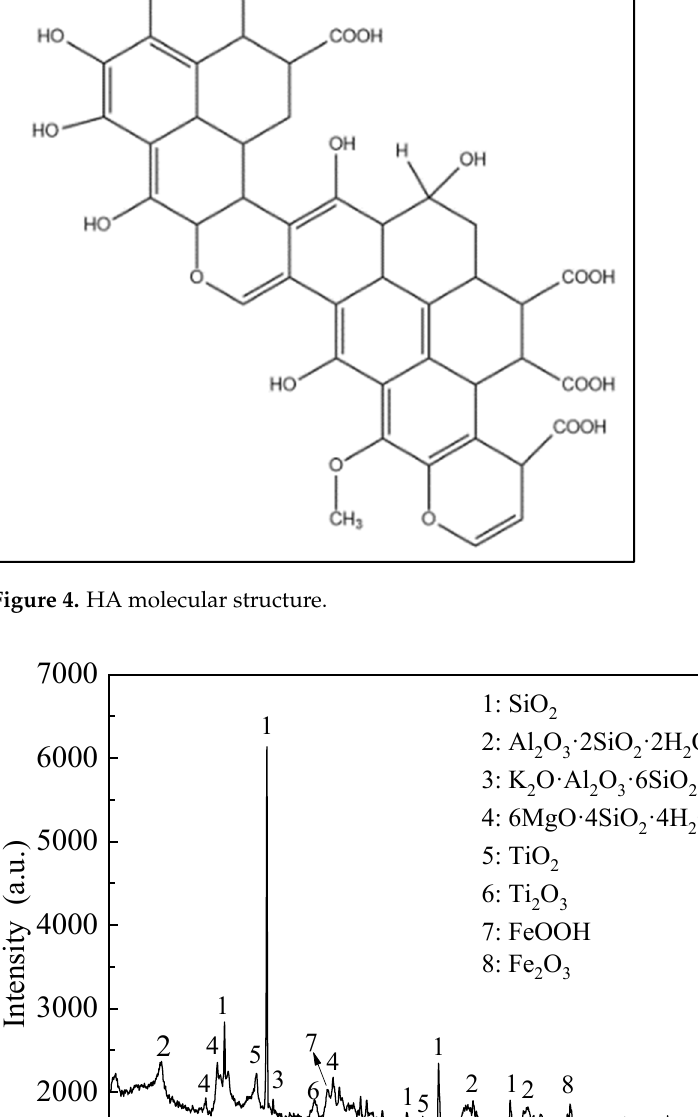
Figure 5. X-ray diffraction pattern of original test soil.